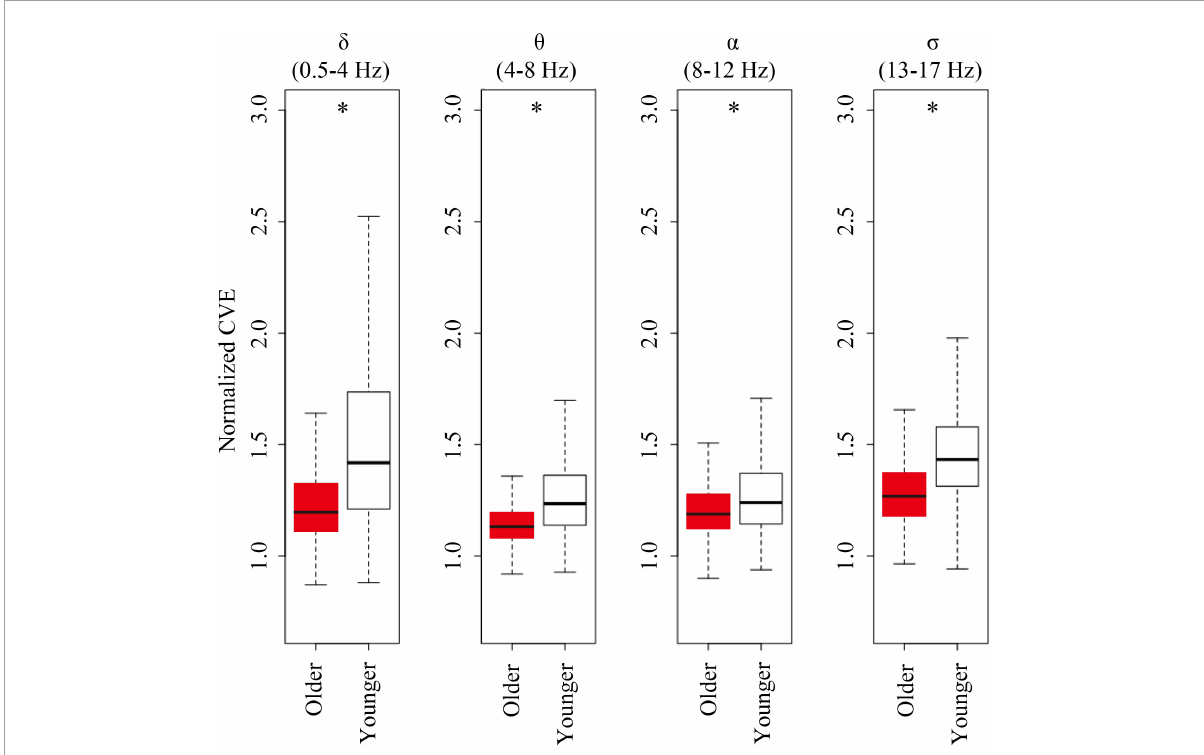
FIGURE6 Envelope analysis of all major spectral bands. Box and whisker plots for each band of envelope analysis. The older group is shown in red, and young group is shown in white in the box. A black line in the box to indicate the mean value, a box to indicate variability ( ± SE), and whiskers around the box to indicate the 95% normal confidence interval for mean. Asterisks represent statistically significant differences between older and young groups ( p <